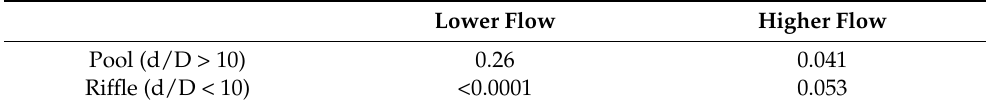
Figure 9. Bed shear stress distribution under ( a ) lower flow and ( b ) higher flow conditions based on the channel geometry classification of depth over median grain size (Table 1). Table 2. p -values from difference of means test conducted between ice-covered and open-water conditions in the pool (d/D > 10) and riffle (d/D < 10) for lower and higher flow conditions.